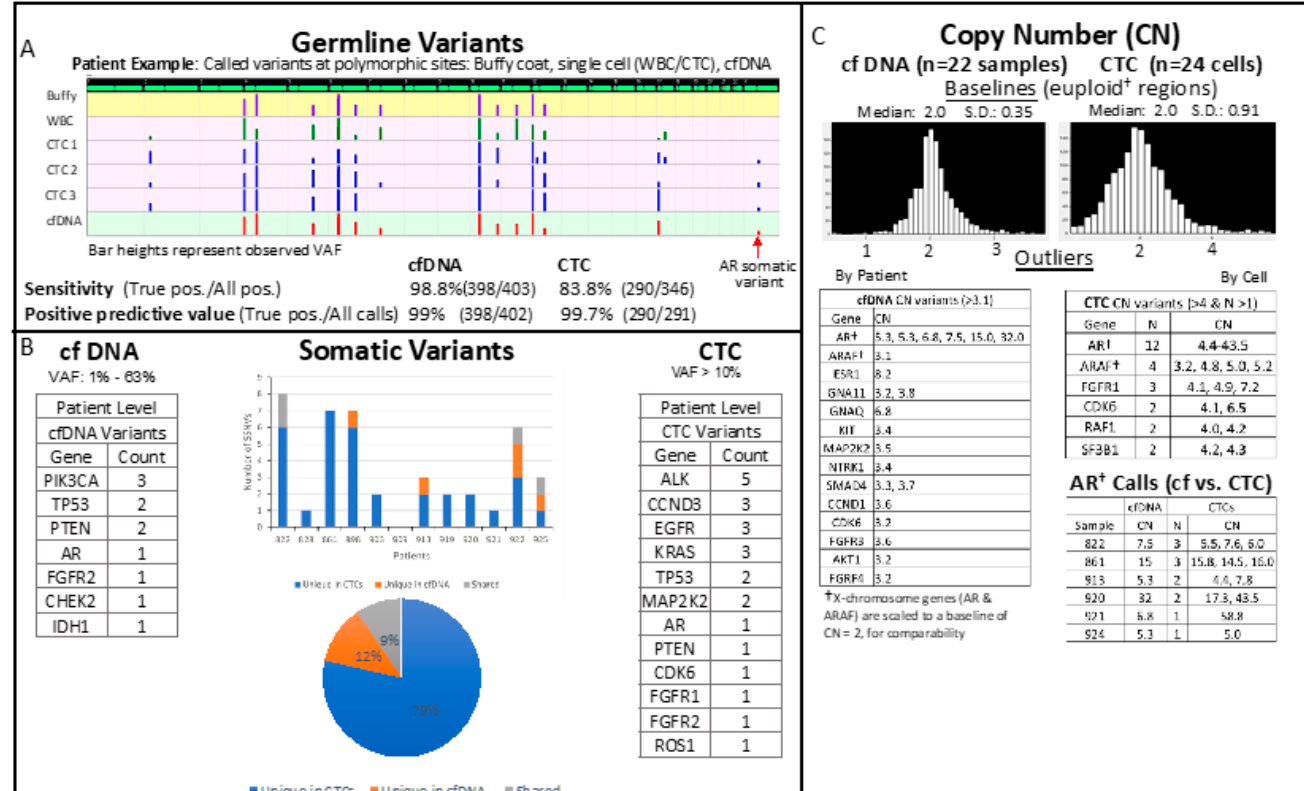
Figure 3. Summary sequencing results of liquid biopsy samples. A . Variant calling sensitivity and positive predictive value estimated using germline variant detection in cfDNA and CTCs. B . Detection of somatic variants in cfDNA and CTC across patient cohort. C . Distribution of gene-level copy number (CN) estimates in cfDNA and CTCs, with copy number variants tabulated separately. Androgen Receptor CN estimates show high consistency, both between cfDNA and CTC analysis, and between CTCs (bottom table).